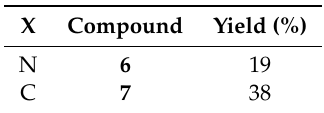
Table 2. Overall reaction yields of the heptaheterocyclic compounds.